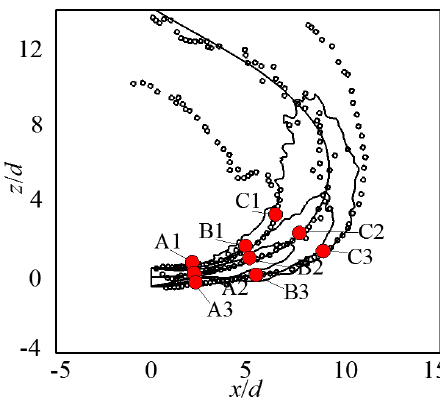
Figure 3. Monitoring points at R = 7.5 and Fr = 5. The image of concentration field is from Lee WY (2006) [16].